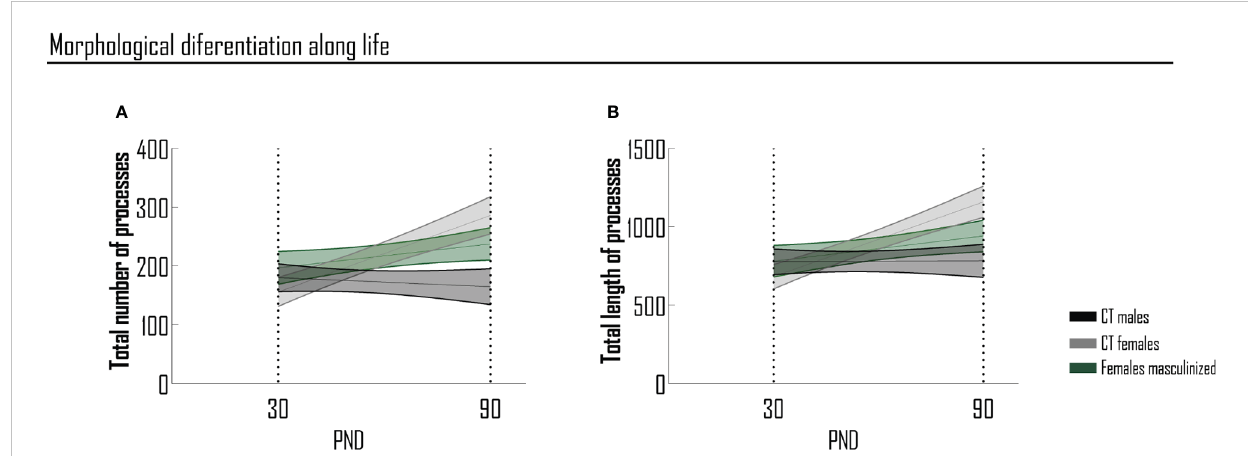
FIGURE 5 Sex-determined temporal changes in the number and length of microglial processes of PFC. Morphological differentiation of microglia considering the total number (A) and the total length (B) of processes per condition and between conditions (slope analysis). Results are presented as mean ± SEM of 28-50 cells. PND, postnatal